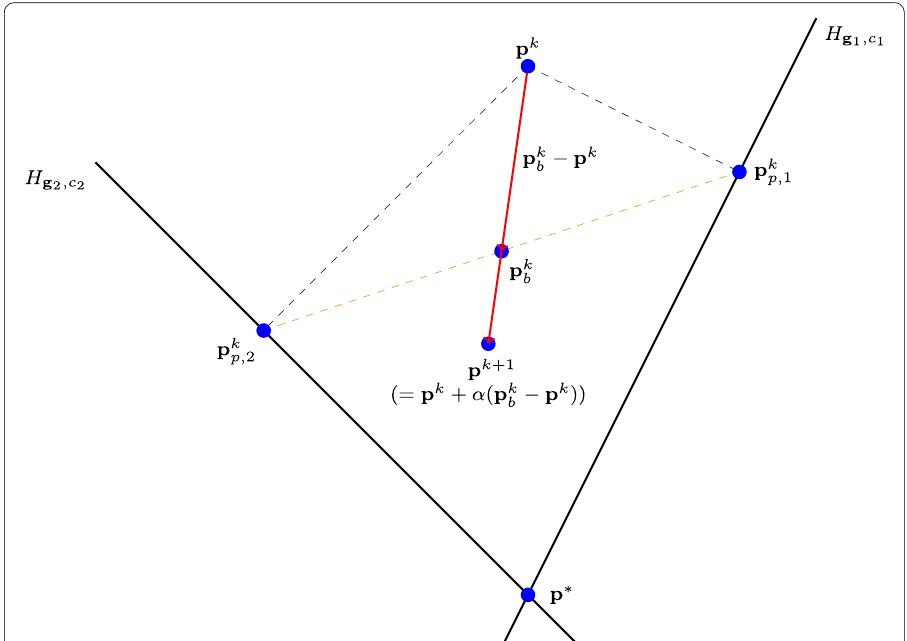
Fig. 1 Visualisation of Cimmino’s algorithm. This figure shows the concept of Cimmino’s algorithm for a two-dimensional problem with two constraints for the iteration step k → k + 1 . In this case, the parameters were defined as w 1,2 = 0.5 and α = 1.5 . The dashed black lines indicate the orthogonal projections of p k onto the hyperplanes, and the dashed orange line indicates the calculation of the barycentre p k b . A choice of different weights w 1,2 would result in the barycentre p k b being shifted along the dashed orange